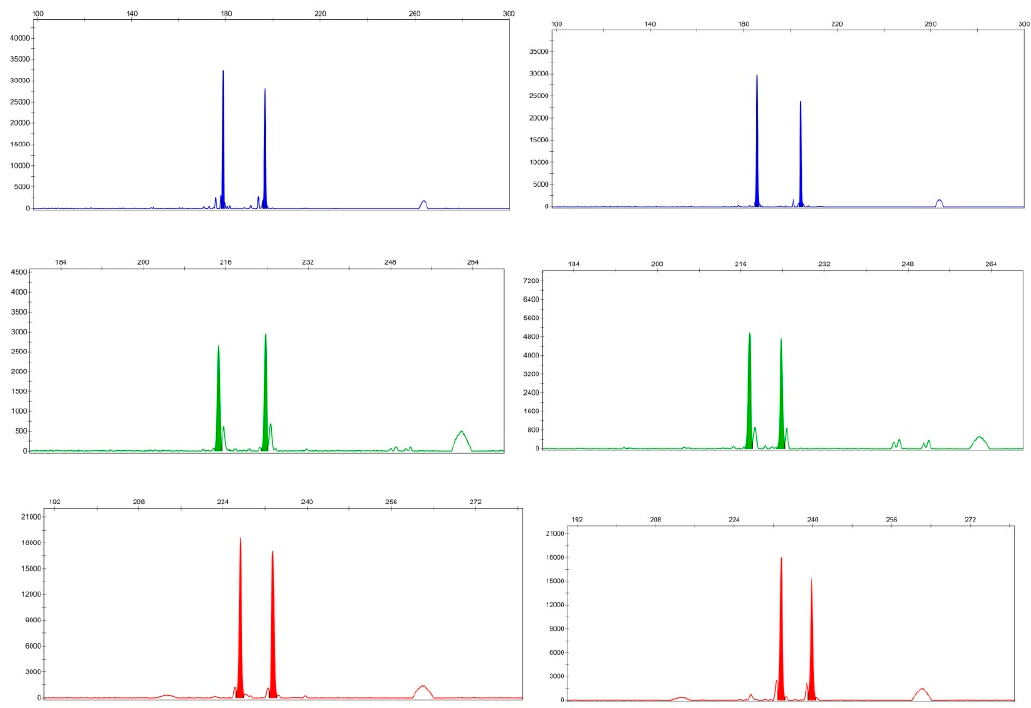
Figure 2. The polymorphisms amplified by primer pair Liq_eSSR10 (blue), Liq_eSSR17 (green) and Liq_eSSR59 (red) in L. formosana samples.